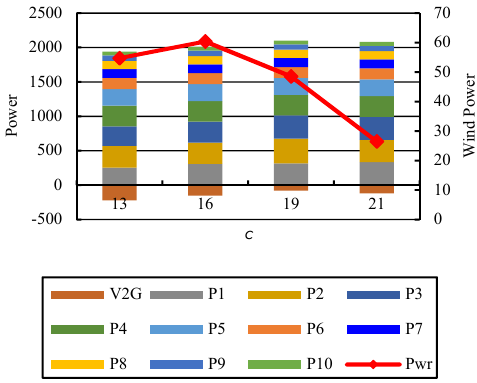
Figure 21. Output power at different scale factors.